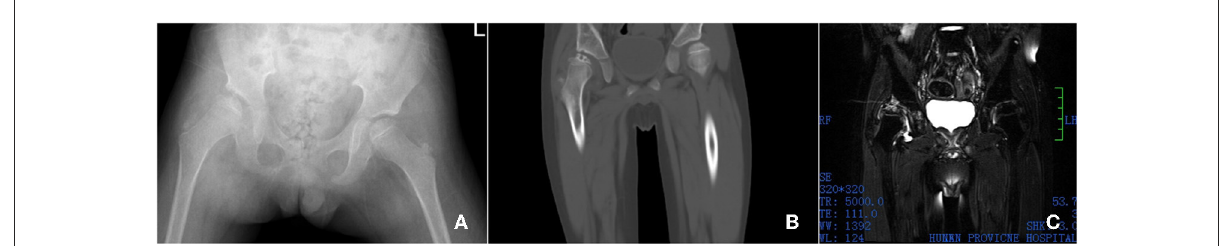
FIGURE1 Imaging examination, X-ray shows the right femoral skull epiphysis becomes flat, smaller, irregular in shape, multiple cystic low-density lesions are seen inside, the right acetabulum is flat, and the right hip joint space is widened. The right femoral head shifted outwards and upwards (A) . CT shows the right femoral head epiphysis was flattened, several microcystic changes were observed on the upper edge, the right femoral head slightly shifted outwards and upward, and the right acetabulum was slightly flattened (B) . MRI showed that the right side Femoral skull epiphysis became flat and local bone collapsed. There were multiple small patchy T2WI hyperintensity shadows under the right femoral metaphysis and right acetabular articular surface (C) .